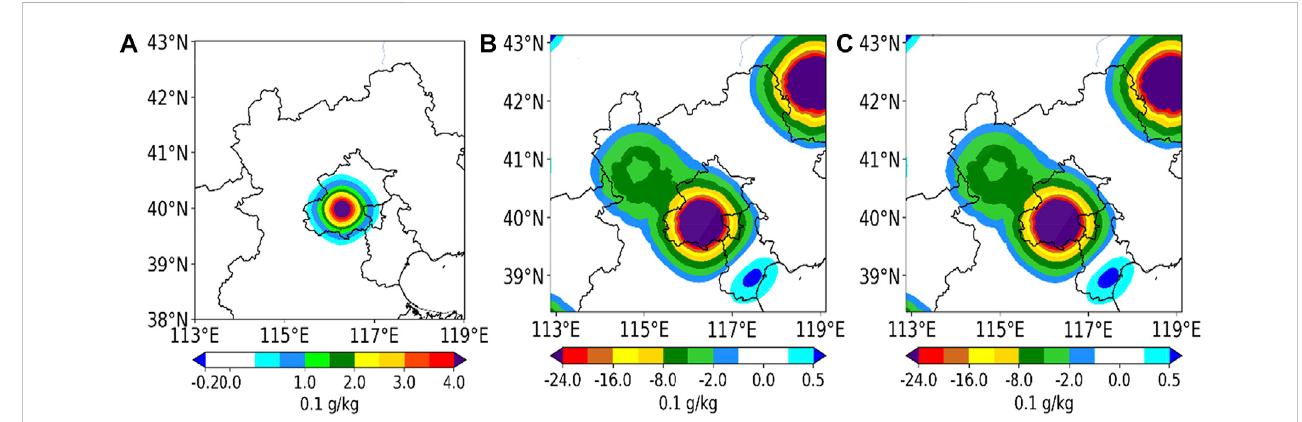
FIGURE 8 Initial speci fi c humidity increments (unit: g/kg) after the fi rst data assimilation from (A) MWR_DA at 850 hPa, (B) AGRI_DA at 500 hPa, (C) A + M_DA at 500 hPa.